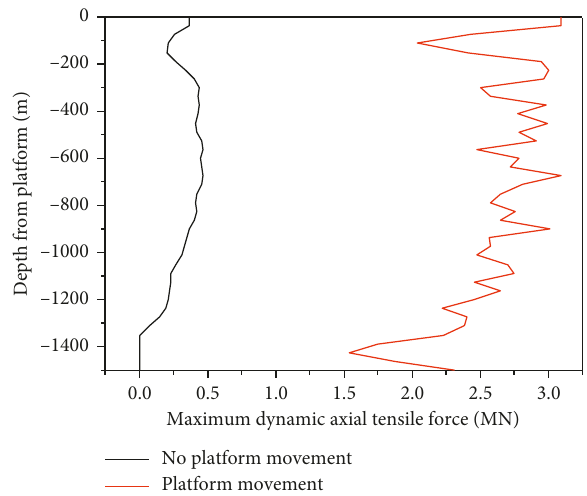
Figure 17: Effect of platform motion on maximum dynamic axial tensile force.